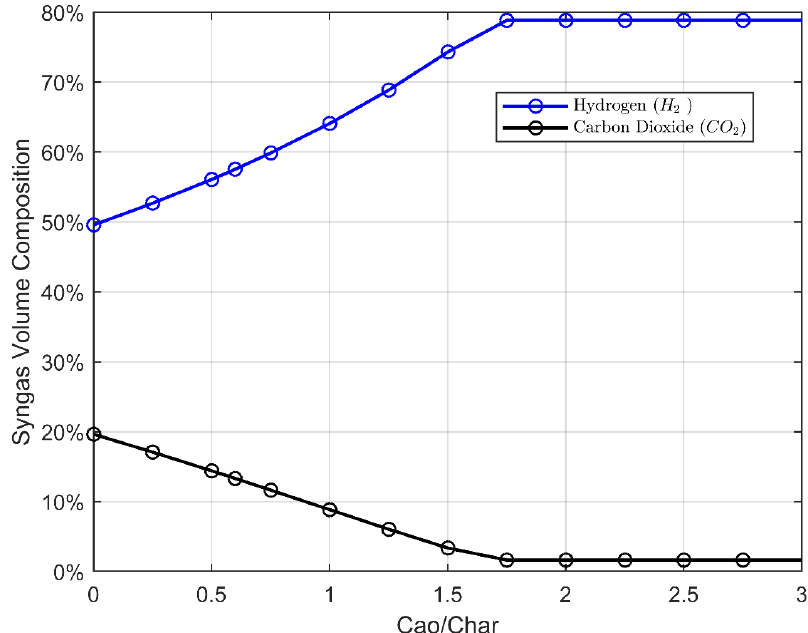
Figure 5. H 2 and CO 2 trend varying CaO to char